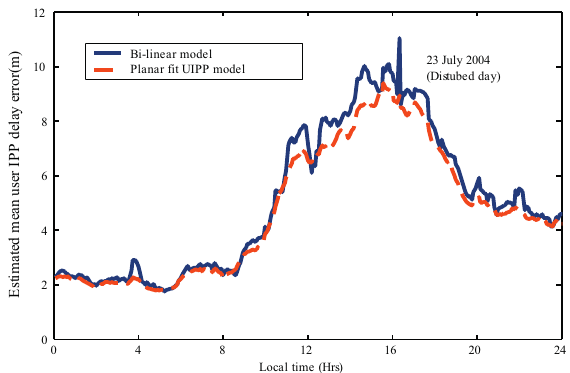
Fig. 6. Estimated mean UIPP delays due to the bilinear interpolation technique and planar fit model (23 July